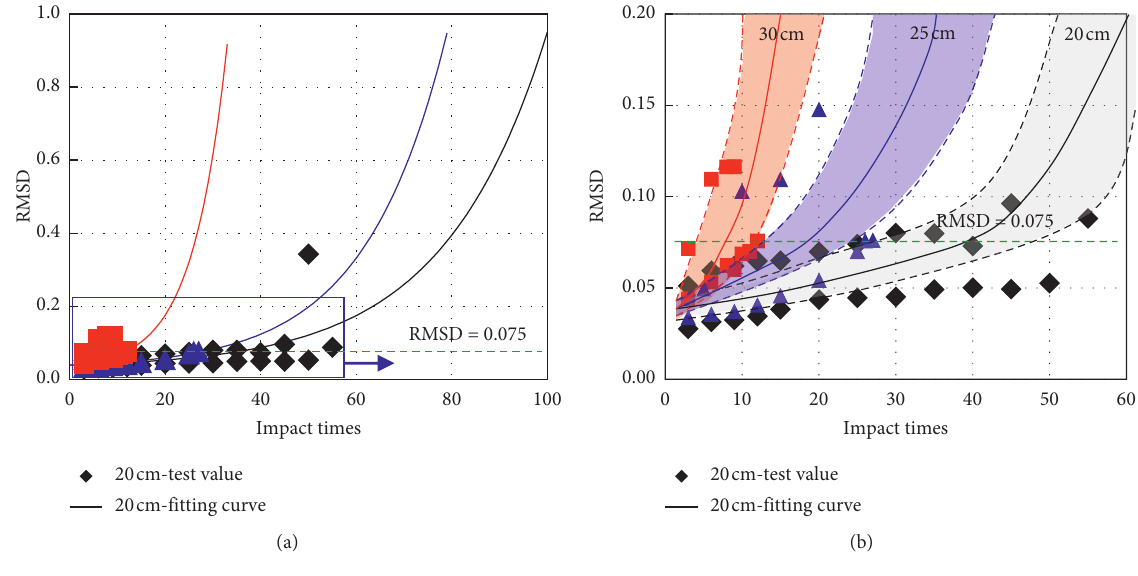
Figure 9: Damage evolution characteristic curves.